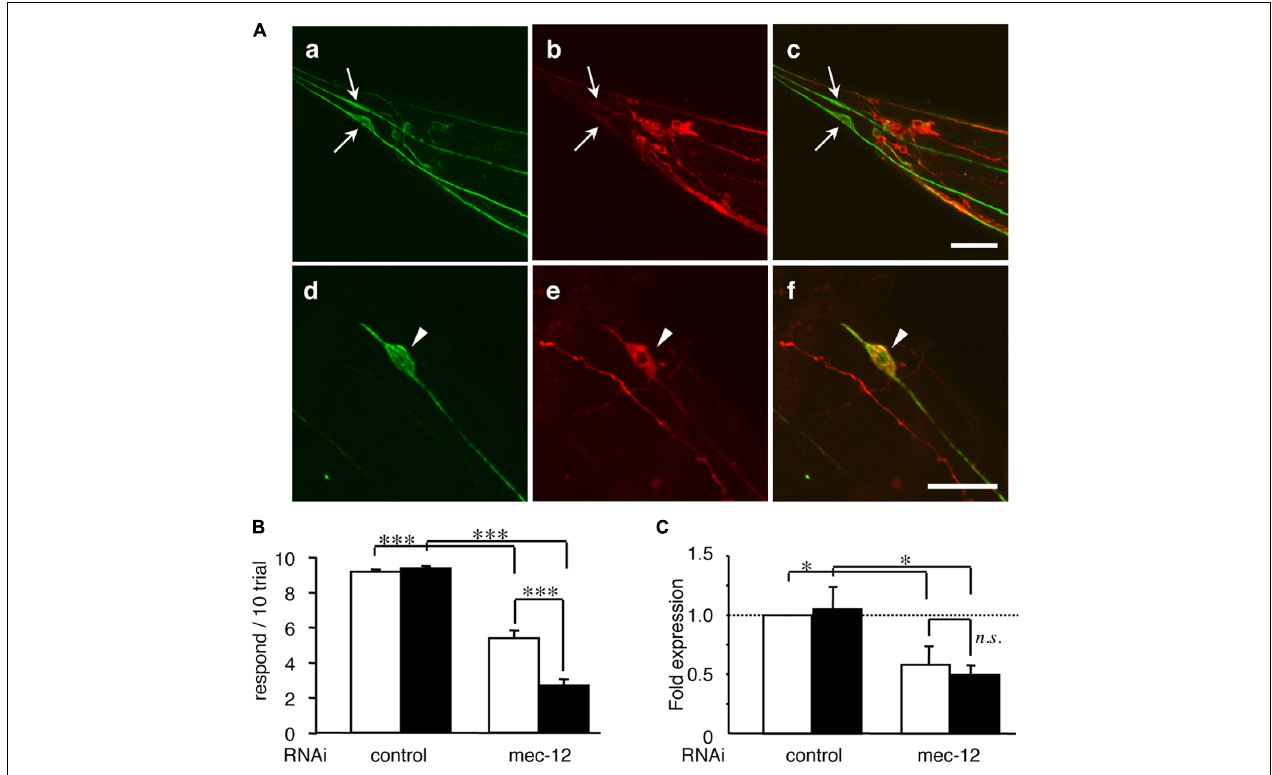
FIGURE 3 | Tau expression in mechanosensory neurons exacerbates touch sense abnormality induced by tubulin knockdown. (A) WT4R(L)-Tg/rrf-3 (a–c) and Mock-Tg/rrf-3 (d–f) worms were subjected to immunolabeling using 6-11B1 (anti-mec-12; a and d ), and pool-2 (anti-tau; b and e ). Merged views are also shown (c and f) . Human tau was expressed in as pan-neuronal pattern ( b and e ) including PLMs (arrows in a–c ) in lumber ganglia and ALMs (arrowheads in d–f ) in the abdomen. Scale bars = 30 µ m. (B) Mock-Tg/rrf-3 (open) and WT4R(L)-Tg/rrf-3 (solid) worms were grown on L4440::T (control) or L4440::mec-12 RNAi plates from embryo to 4 days after hatch. Touch sensitivity was analyzed as described in the Materials and Methods section (means ± SEM, n = 60). (C) The expression of mec-12 mRNA in the indicated worms was quantified by quantitative real time RT-PCR (means ± SEM, n = 3). Statistical significance was analyzed by Tukey’s post hoc test ( ∗ p < 0.05 , ∗∗∗ p < 0.001